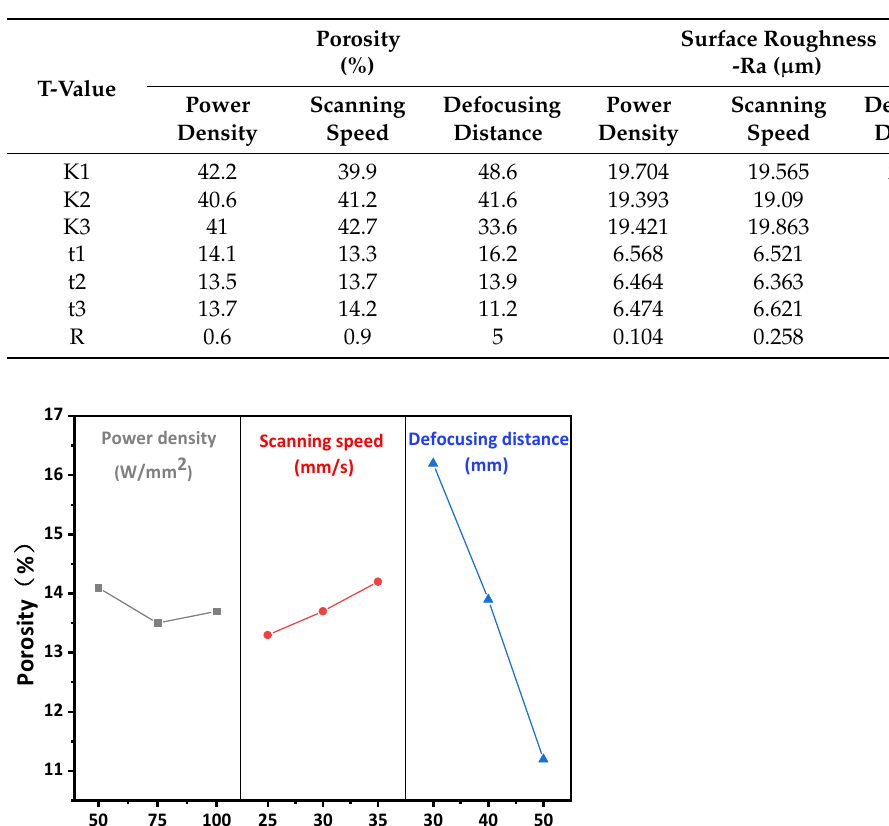
Table 3. T value analysis of laser micromelting reaction.